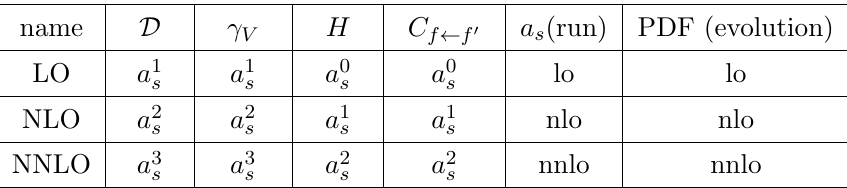
Table 2 . The adjustment of perturbative order for the cross-section in the improved (cid:13) picture. For explicitness we indicate the highest included power of a s in the